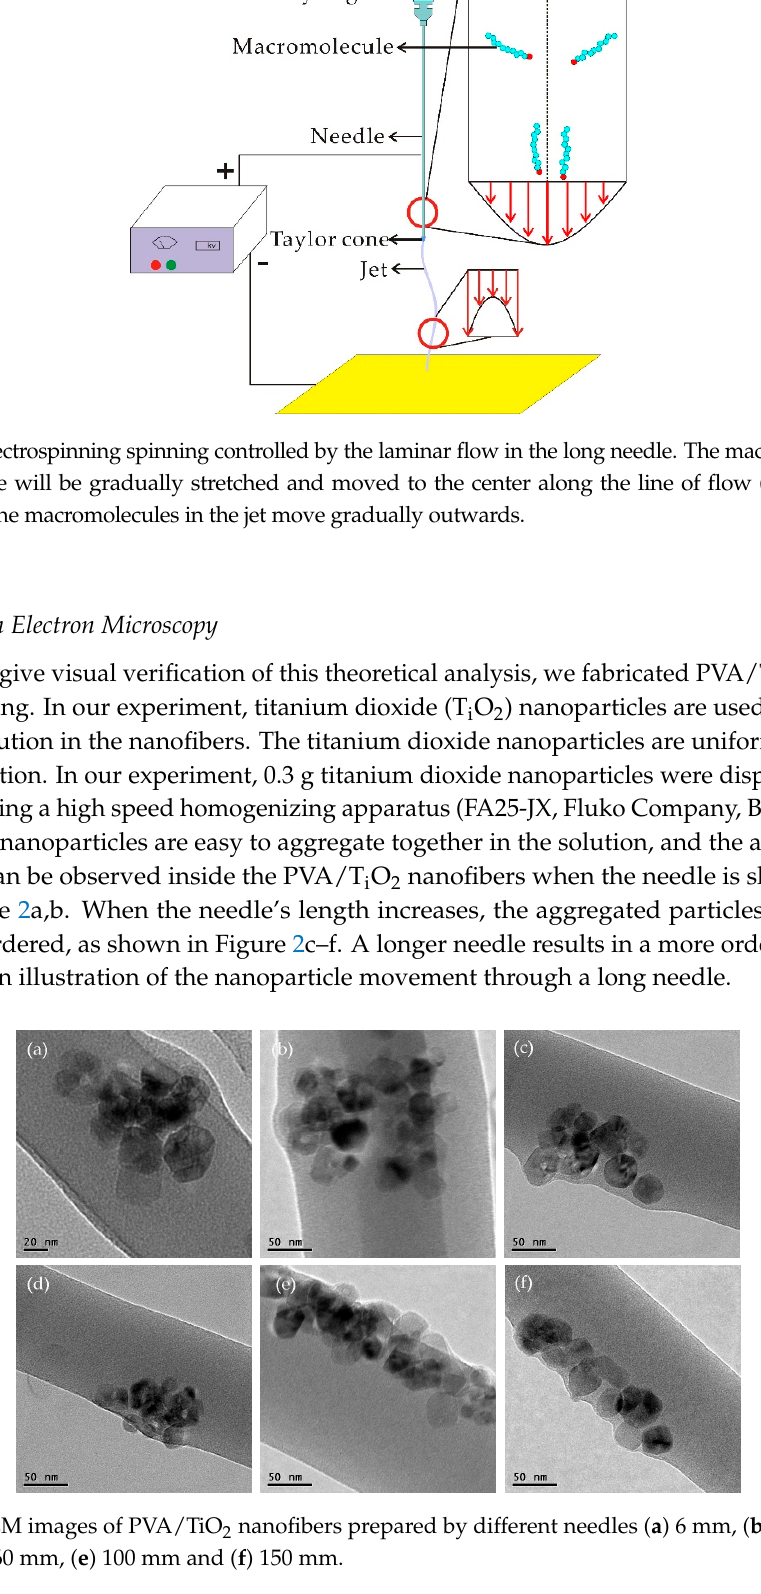
Figure 3. Nanoparticle movement in a long needle. The particle in the center moves fastest, and that far from the center moves slowly and is pushed gradually into the center. 4.2. XRD Spectra In order to verify the macromolecule orientation in the fiber, we used XRD spectra to measure the crystallinity of the obtained fibers. Crystallinity is a good index for the degree of structural order, and polymer molecule orientation greatly affects the crystallization of the polymer. Higher crystallization implies less chain entanglement [29]. X-ray diffraction (XRD) has been widely used to study crystal structure to reveal a molecule’s orientation in a polymer. In this paper, XRD analysis was applied to elucidate the effect of the needle’s length on the crystalline structure of PVA membranes; their XRD patterns with characteristic crystalline peaks are shown in Figure 4.